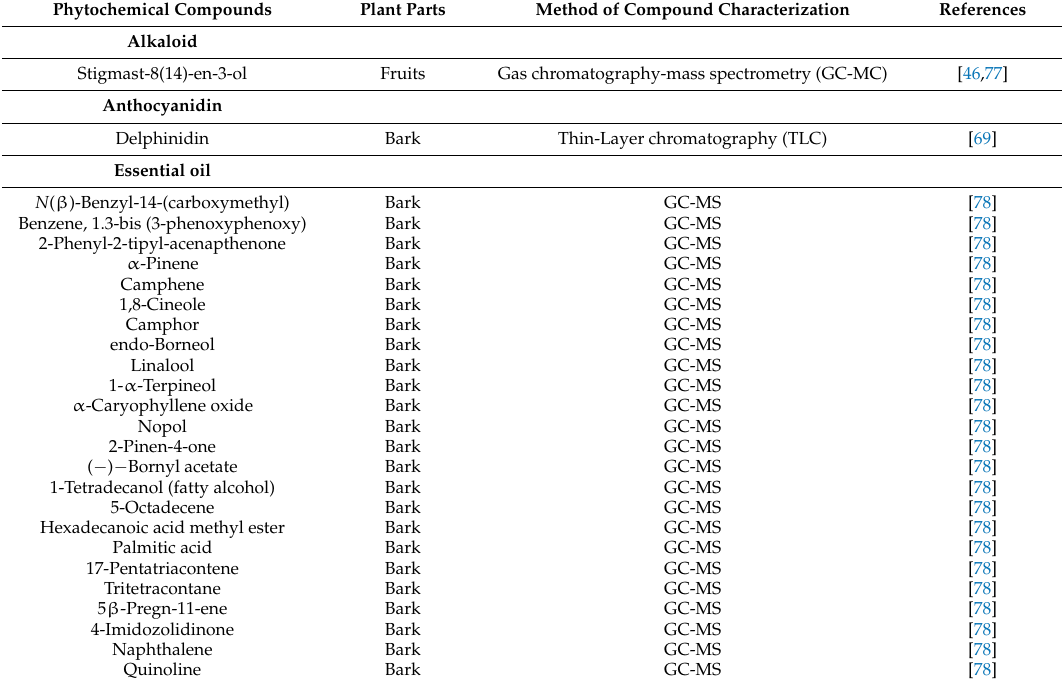
Table 3. Phytochemical compounds isolated from the bark, leaves and fruits of B. micrantha . Phytochemical